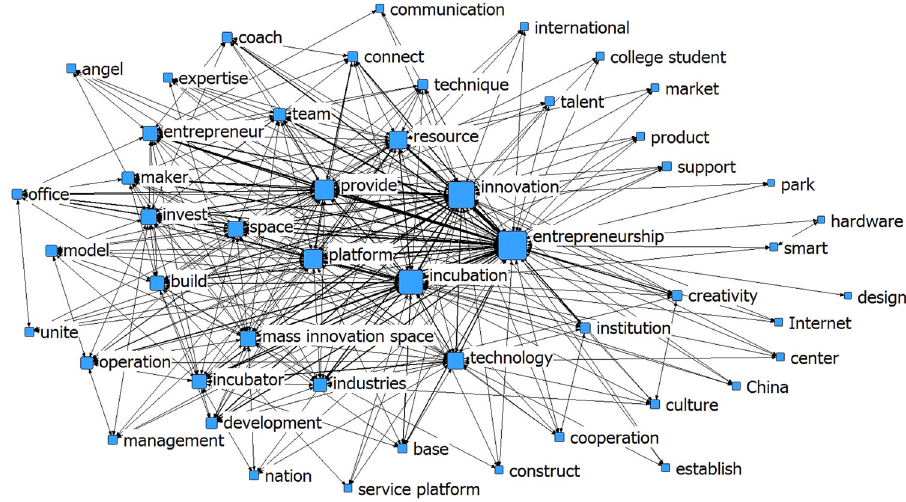
Fig. 2 Semantic network of MIS self-de fi ning statements. This fi gure demonstrates the semantic network results of MIS self-de fi ning